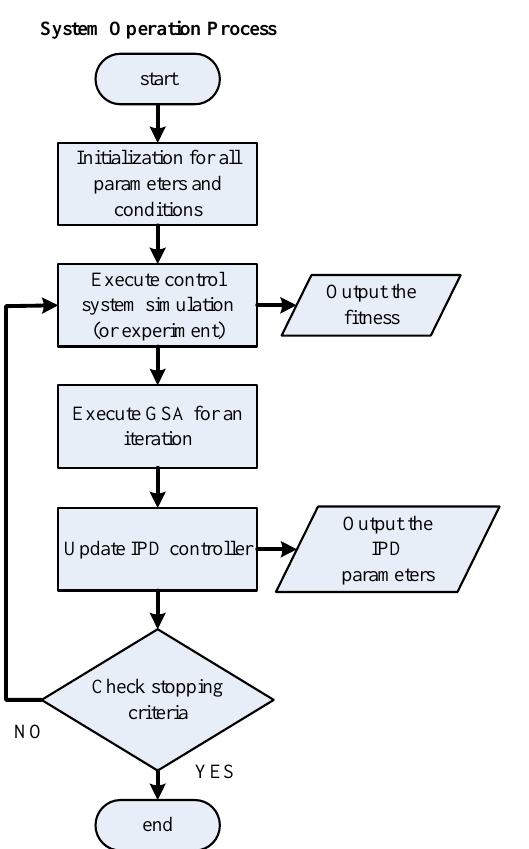
Figure 4. Flowchart of system operation process.